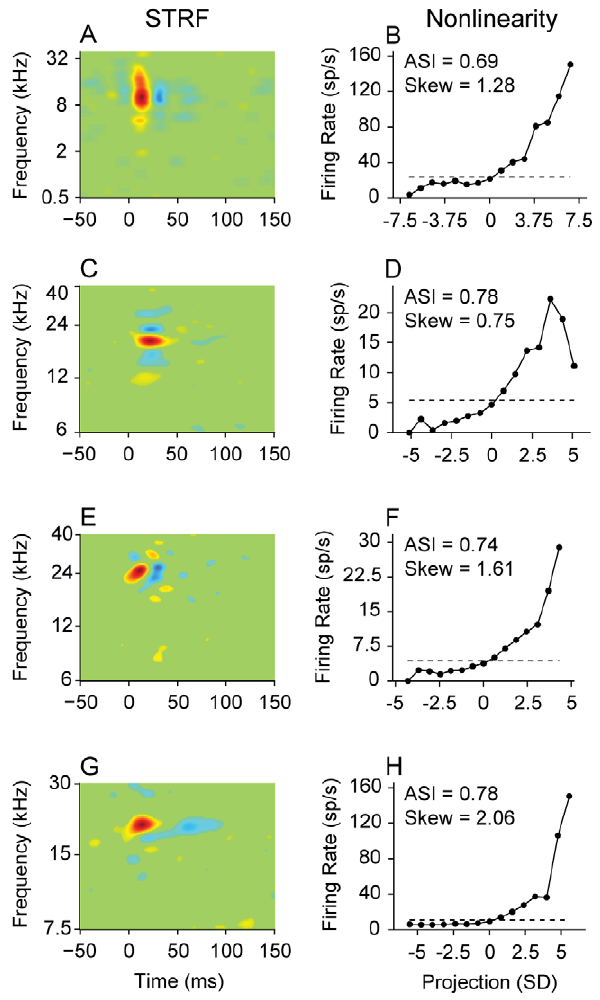
Figure 10. STRF and nonlinearity examples. Each row corre- sponds to one neuron. (A) BT neuron STRF and (B) corresponding nonlinearity. Dashed line: average firing rate of the neuron during the ripple stimulus. Noted for each neuron are: nonlinearity asymmetry index (ASI; asymmetry of nonlinearity) and nonlinearity skewness (Skew). Firing rate increases as the projection of the stimulus onto the STRF increases (or, equivalently, as the correlation, or similarity, between the stimulus and the STRF increases). (C–H) additional STRF- nonlinearity examples. Abscissas of nonlinearities are in units of standard deviation (SD), where the value indicates the stimulus similarity relative to a randomly selected stimulus pattern. Example: a value of 3 SD represents a similarity value that would on average not be expected for a randomly spiking neuron.